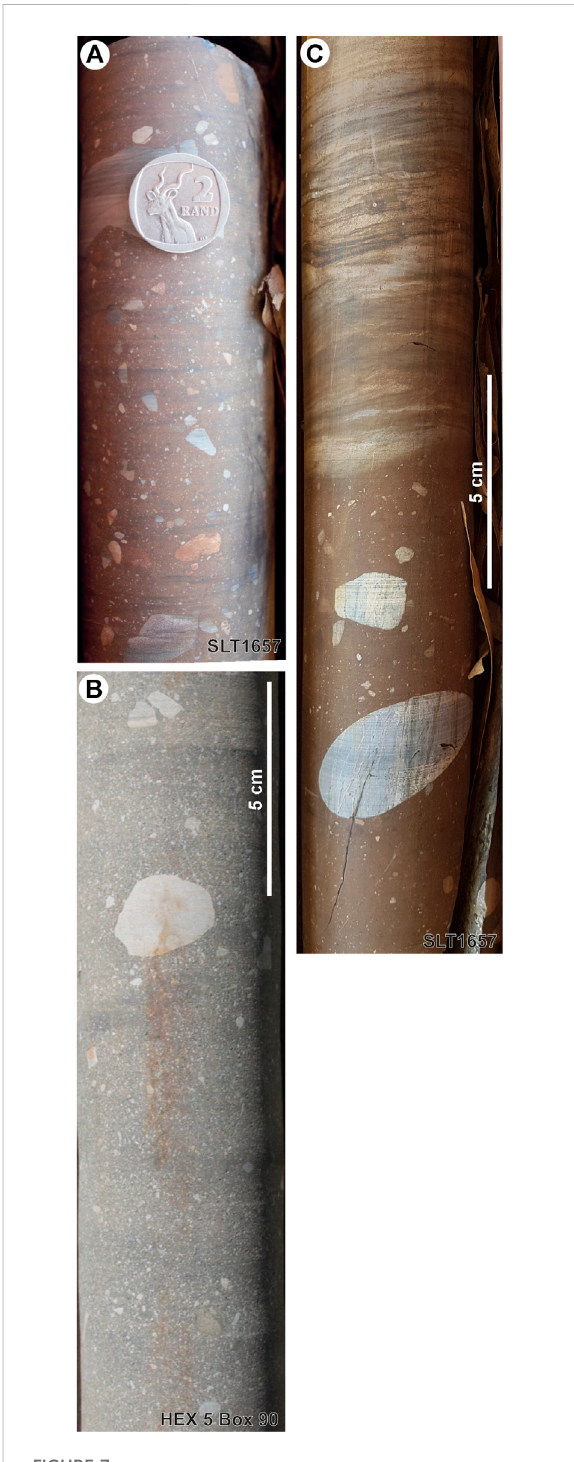
FIGURE 7 Detail of facies from core photographs. (A) Massive, ferruginous diamictite with clay-rich matrix from the SLT1657 core. (B) Pebbly sandstone with diffuse, subparallel strati fi cation, from the HEX 5 core. (C) Contactbetweenmassive, clast-poor diamictiteand strati fi ed diamictite in core SLT1657. The stratigraphic position of each of the photographed core intervals are shown on Figure